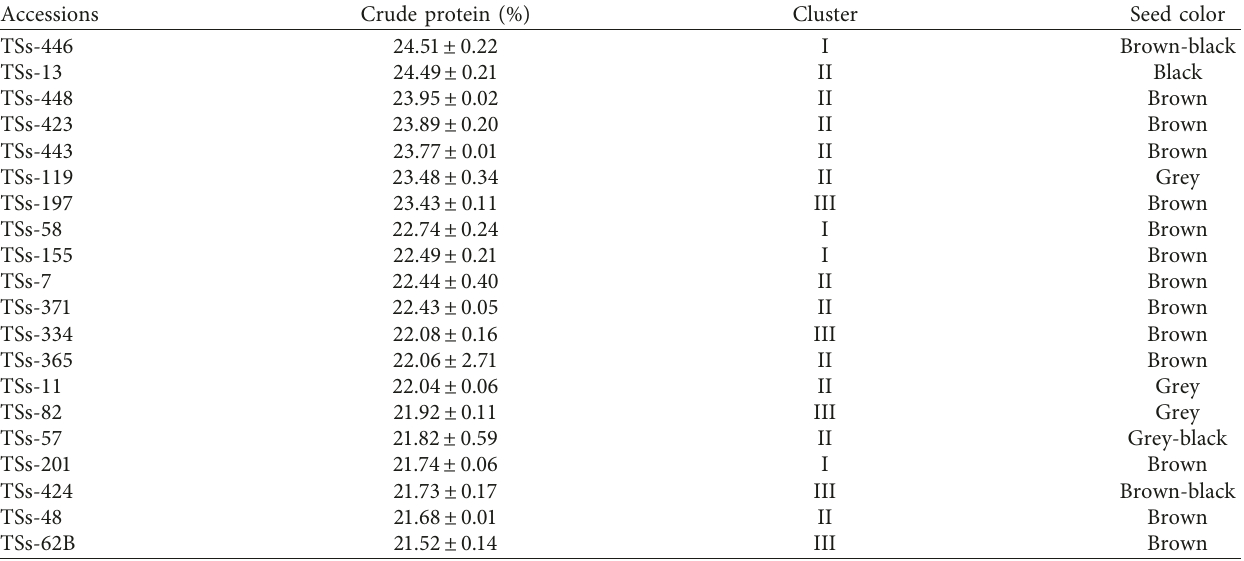
Table 4: Crude protein content, seed color of 20 AYB accessions by hierarchical